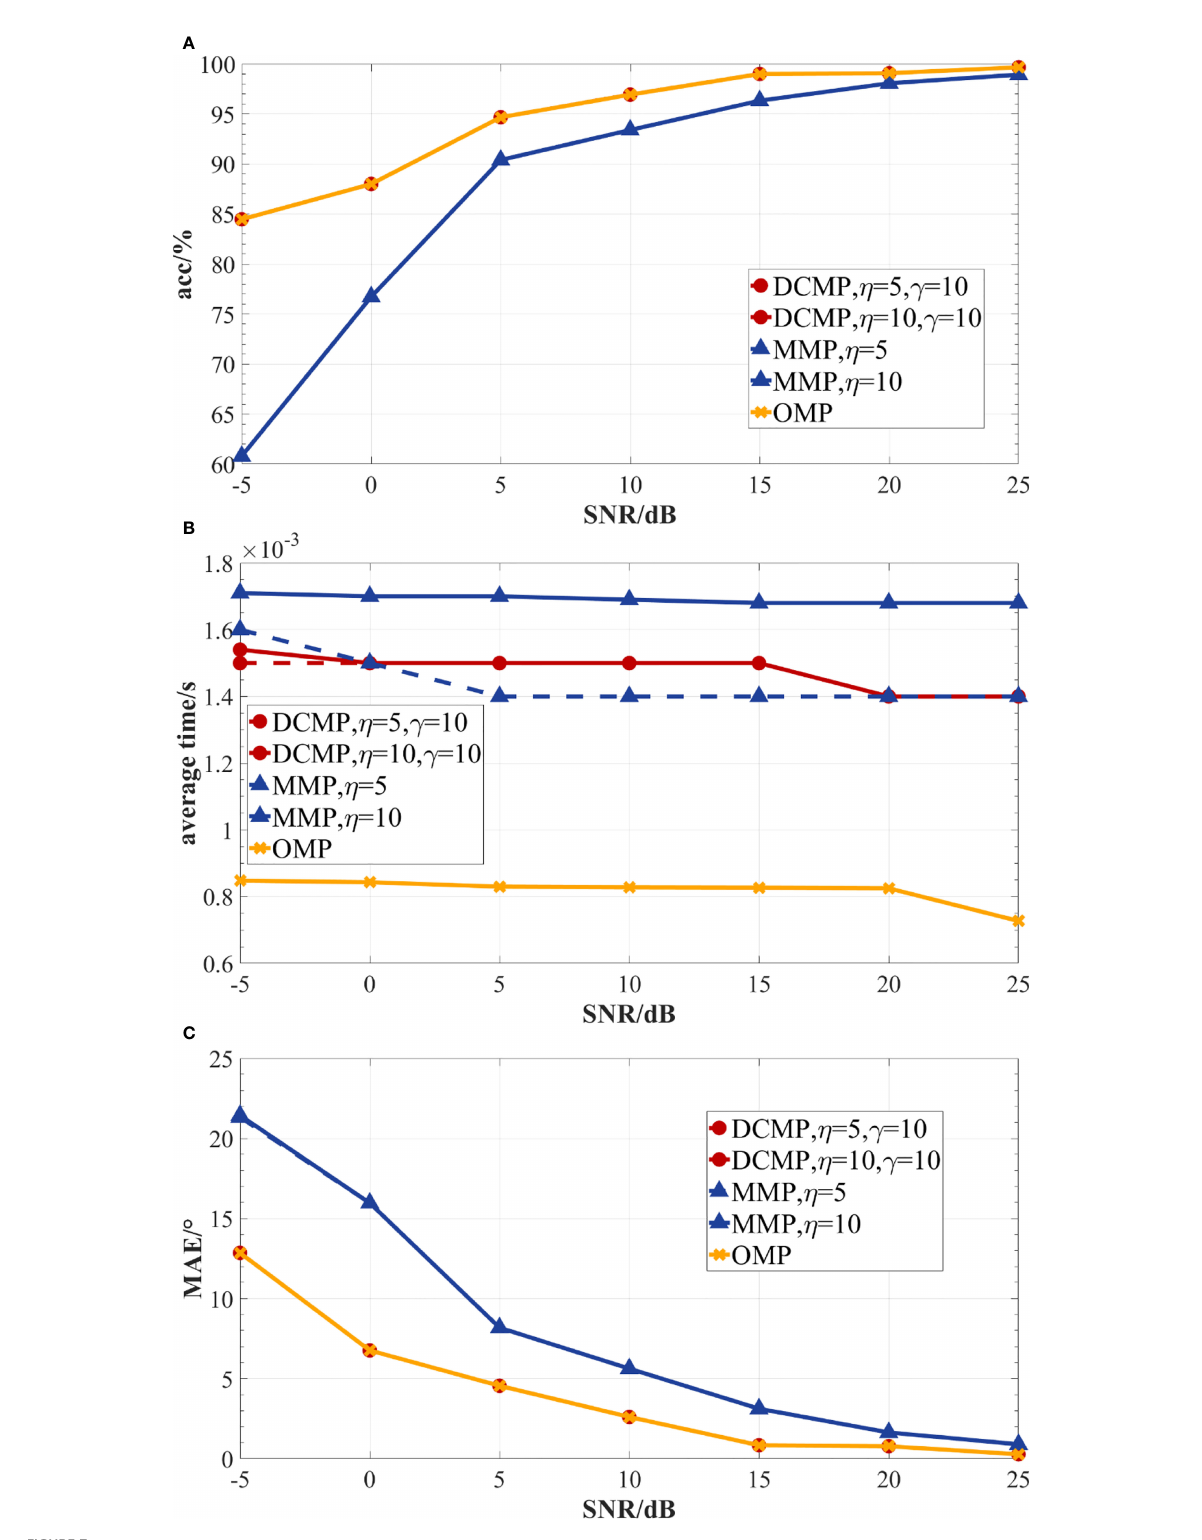
FIGURE 7 The performances of the DCMP, MMP, and OMP algorithms under different SNR values for one source, a 12-element array, and 96 snapshots. (A) DOA prediction accuracy; (B) average estimation time; (C)